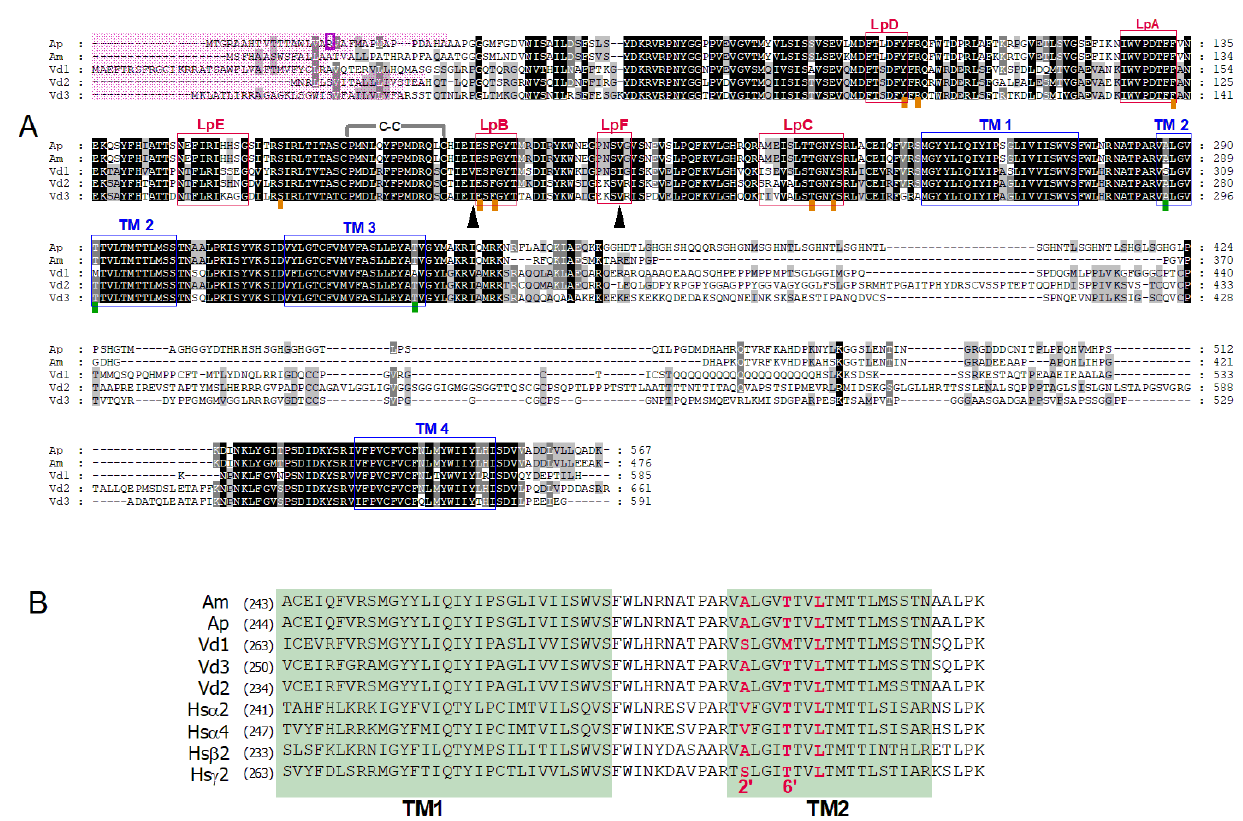
Figure 1. ( A ) Alignment of Ap -RDL1 (AXY92182.1), Am -RDL (AJE68941.1), Vd -RDL1 (AVY53069.1), RDL2 (AYR04938.1) and RDL3 (AVY53071.1) amino acid sequences. Loops involved in GABA binding (LpA-F) are boxed in red, transmembrane segments (TM1-4) are boxed in blue. Amino acids that have been shown to be involved in GABA binding are underlined with a brown square and those in non-competitive antagonists binding with a green square. The location of the C->R substitution in our Ap -RDL1 clone is boxed in purple. ( B ) Enlargement of the TM1-TM2 sequence alignment with key amino acids for non- competitive antagonists at 2′, 6′ and 9′ locations bolded in red. Human sequences for α 2 , α 4 , β 2 and γ 2 GABA-A receptor subunits are also presented.